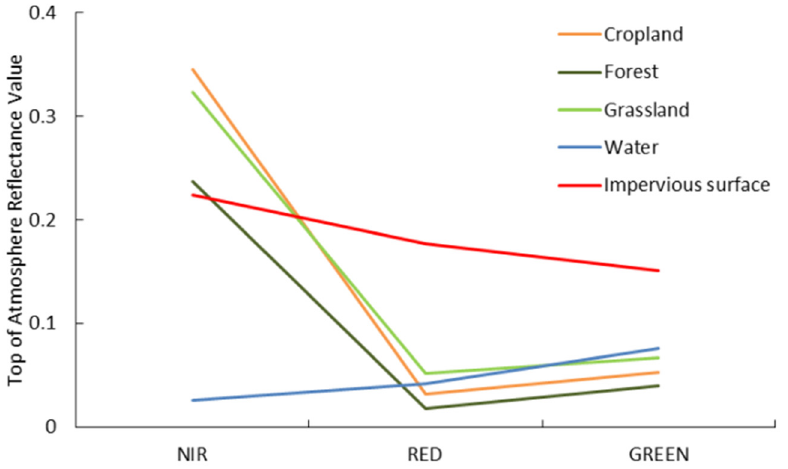
Figure 6. Spectral reflectance curves of different land cover types in the NIR, red and green bands. (4)